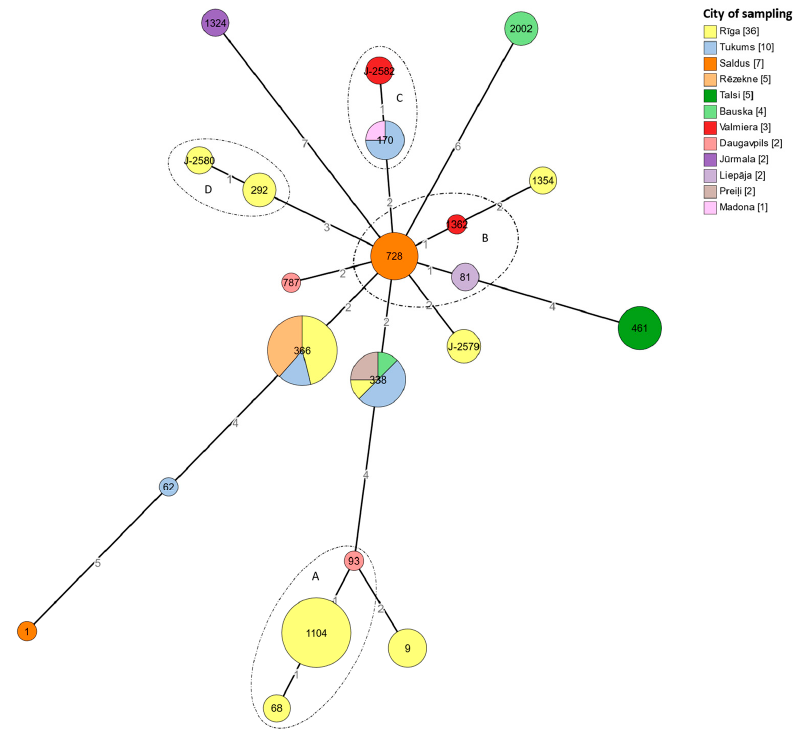
Figure 3. A minimum spanning tree of 79 L. pneumophila isolates from water samples taken in hotels in Latvia, based on SBT. The node sizes are proportional to the numbers of isolates sharing an identical pattern. Each node color represents the geographic origin of the isolate. The relative branch length scaling is maintained to project the internodal distance. The clonal complexes (A–D) generated at a single locus variant level are indicated by the circles surrounding the nodes.